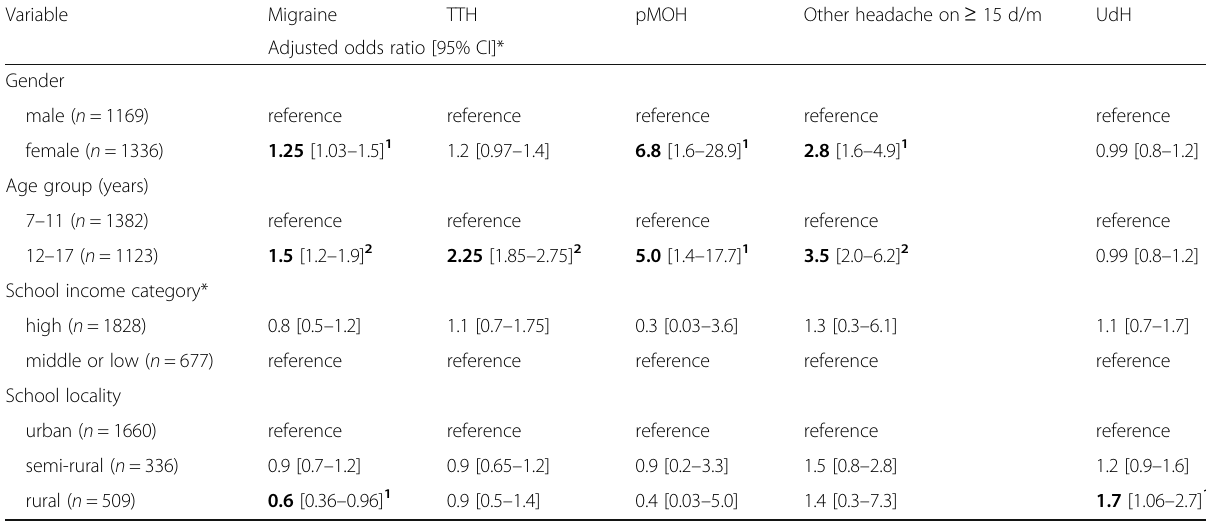
Table 4 Multivariate logistic regression analyses of headache type versus demographic variables ( N = 2505)